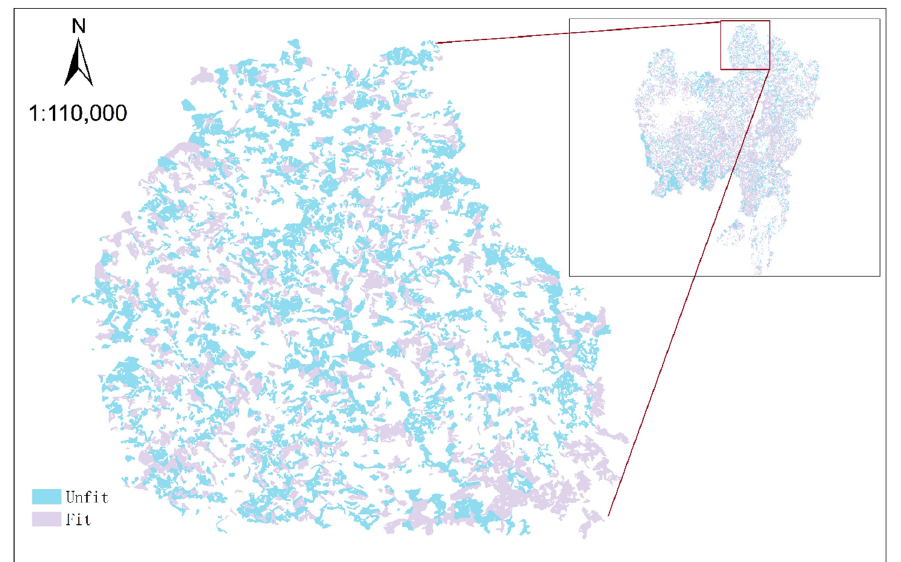
Figure 2. Suitable areas for multifunctional management. In the figure, the “unfit” indicates that this type of forest area is not suitable for multifunctional forest management, and the “fit“ means that the regional forest stand is suitable for multifunctional forest management.